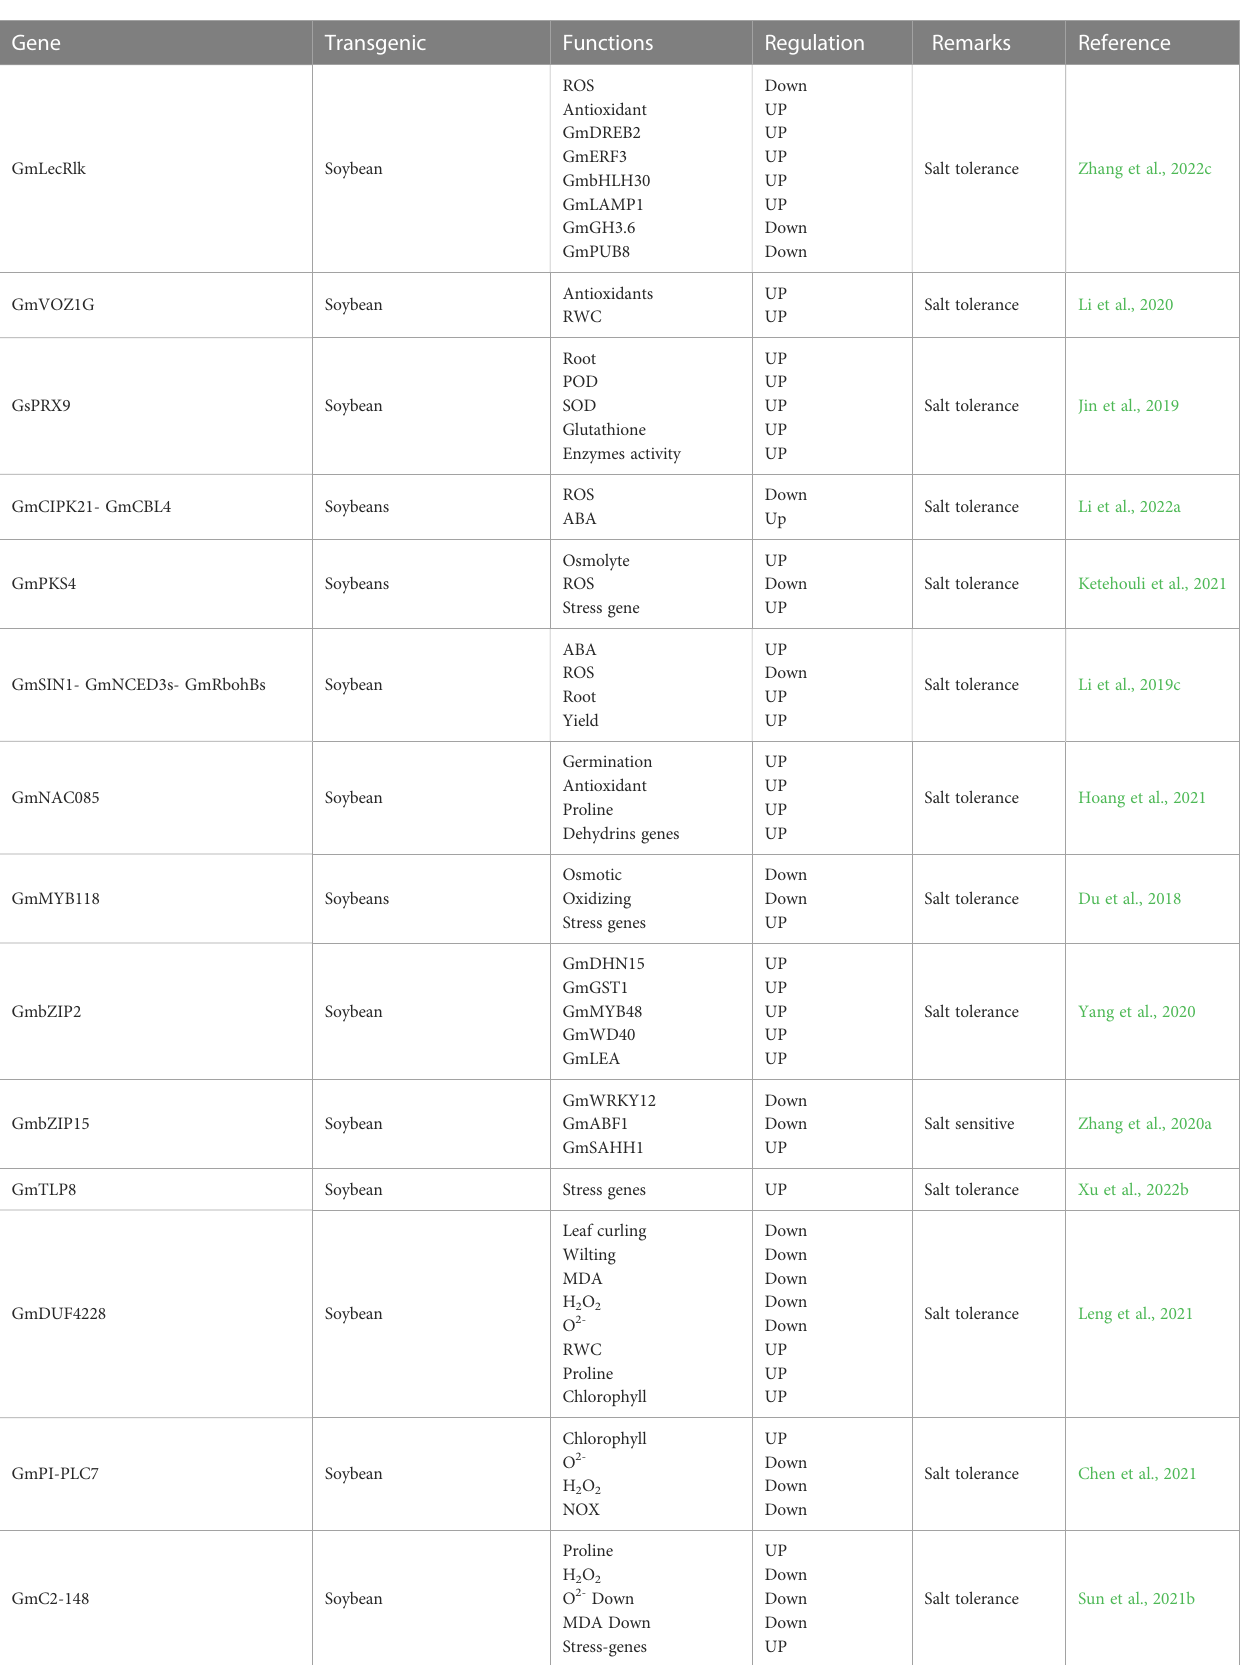
TABLE 2 Summary of functional validation of salt related genes in